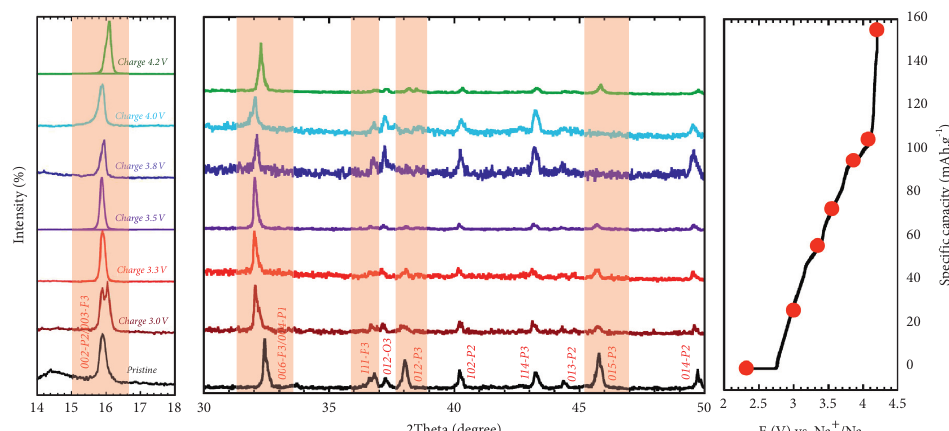
Figure 5: XRD patterns of the P2/P3-NaNMC electrode at various charge stages during the first